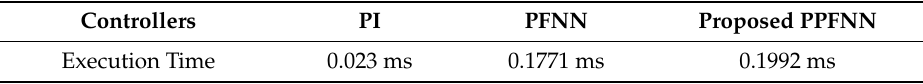
Table 3. Execution time of shunt APF using PI, PFNN and proposed PPFNN